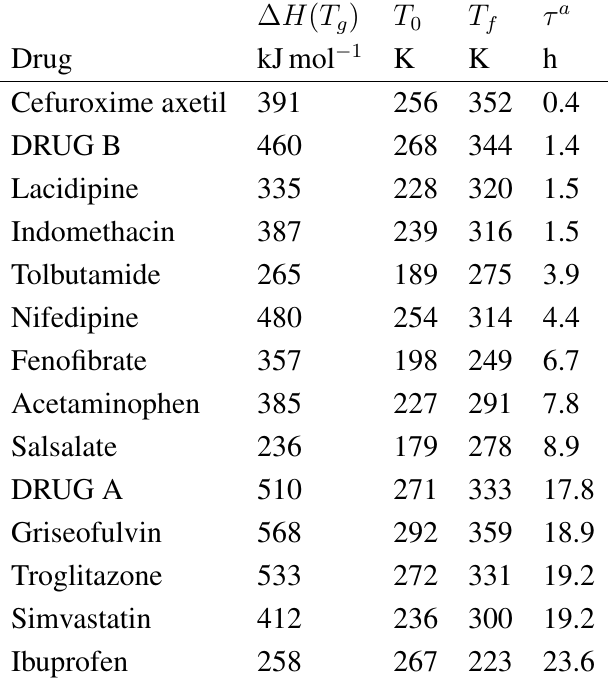
Table 2. Parameters required for the calculation of (cid:28) using the AG equation − 20 ( a relaxation time at T g